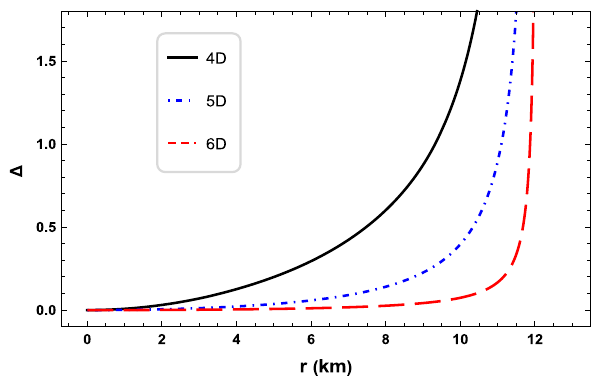
Fig. 7 Comparison of radial variation of anisotropy factor ( (cid:11) ) in PSR J0348+0432 for α = 25 in 4D, 5D and 6D